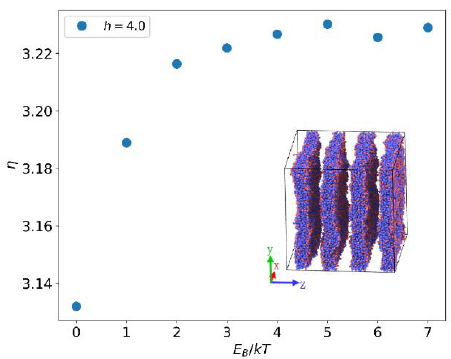
Figure 11. Dependence of the viscosity 𝜂 on 𝐸 𝐵 . Inset shows a perpendicular lamellar structure with the gradient of the shear flow in x direction. the gradient of the shear flow in 𝑥 direction.